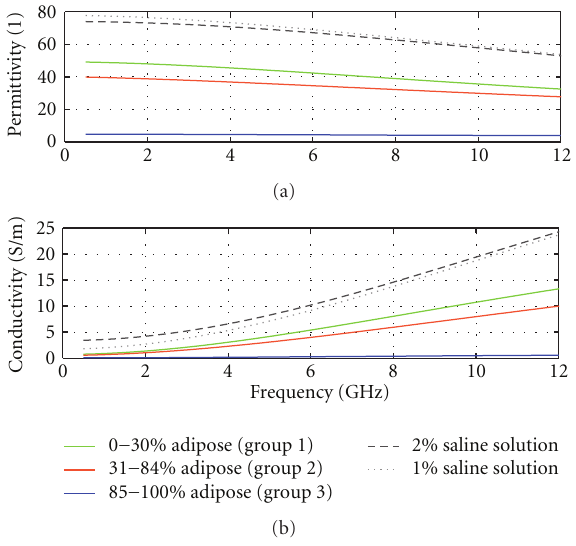
Figure 2: Relative permittivity and conductivity of the 3 breast tissue groups, as well as 1% and 2% saline solutions.